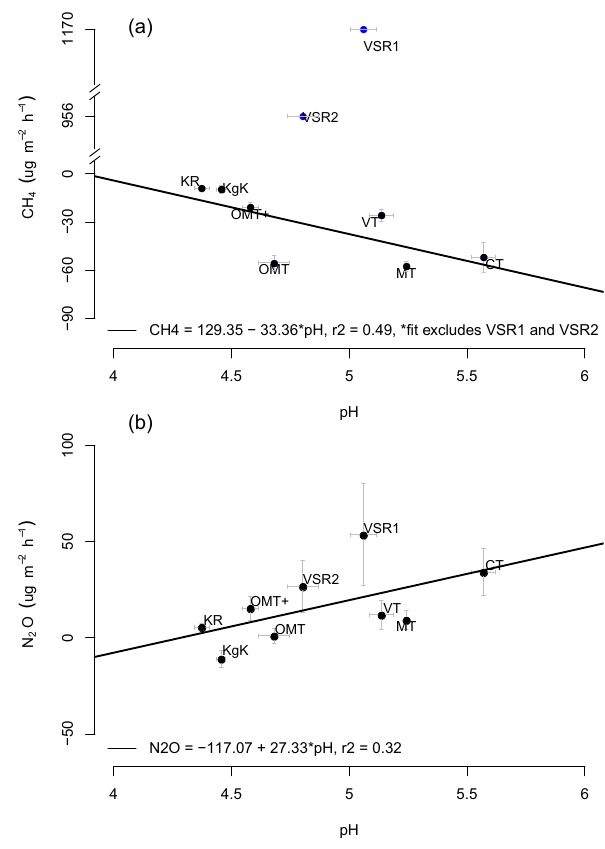
Figure 8. Scatterplot between site-specific mean pH and mean flux (µgm − 2 h − 1 ) of (a) CH 4 or (b) N 2 O of summer with intermediate moisture over the period of soil water sampling campaign (July– September 2005). Error bars show standard error. The CH 4 error bars for VSR1 and VSR2 are not